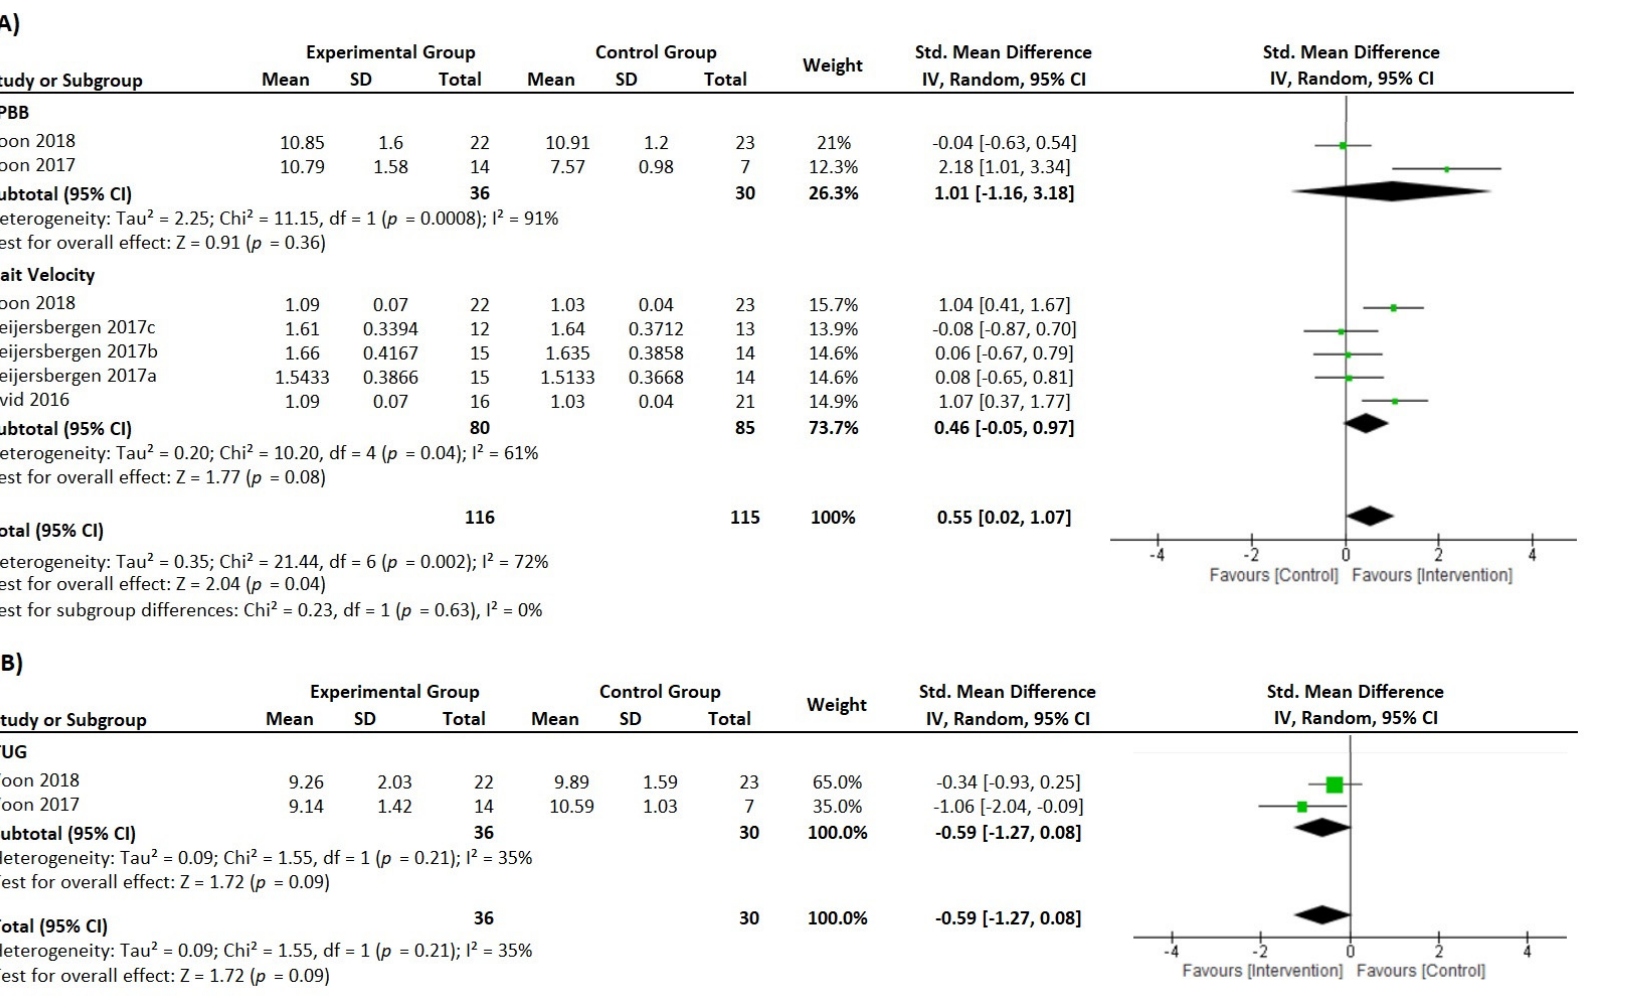
Figure 4. Forest plot presenting standardized mean difference and 95% confidence intervals from studies reporting high-speed resistance-training-induced changes in physical function (( A ), through SPBB and gait velocity; ( B ), through TUG) between the intervention groups and the control groups. IV, independent variable; CI, confidence interval; SMD, standardized mean difference; SPPB, short physical performance battery; TUG, timed up and go test